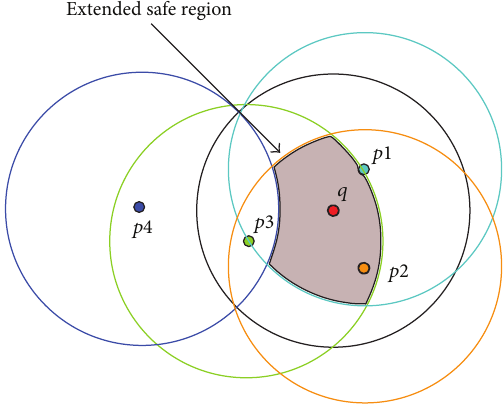
Figure 4: Extended Safe